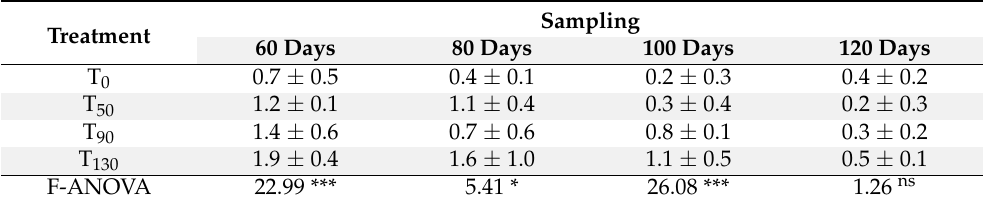
Table 13. Nickel content ( µ g/L) in leachates. Entries represent means ± standard errors from n = 3 replicates.